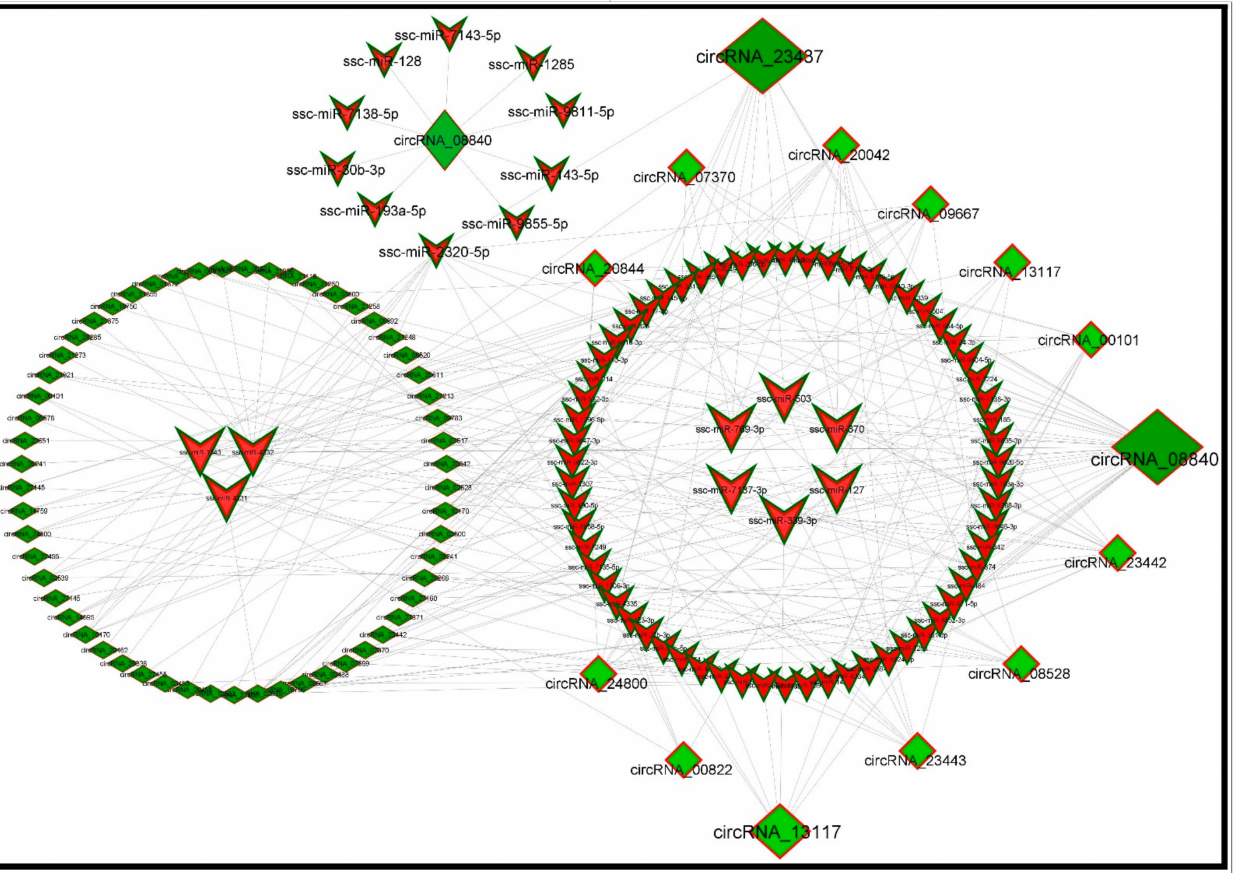
Figure 3. A network of differentially expressed circRNAs and their target miRNAs in intramuscular fat tissues. The square green nodes represent circRNA and the red triangular nodes represent miRNA. The increasing sizes illustrate the higher levels of interaction with each